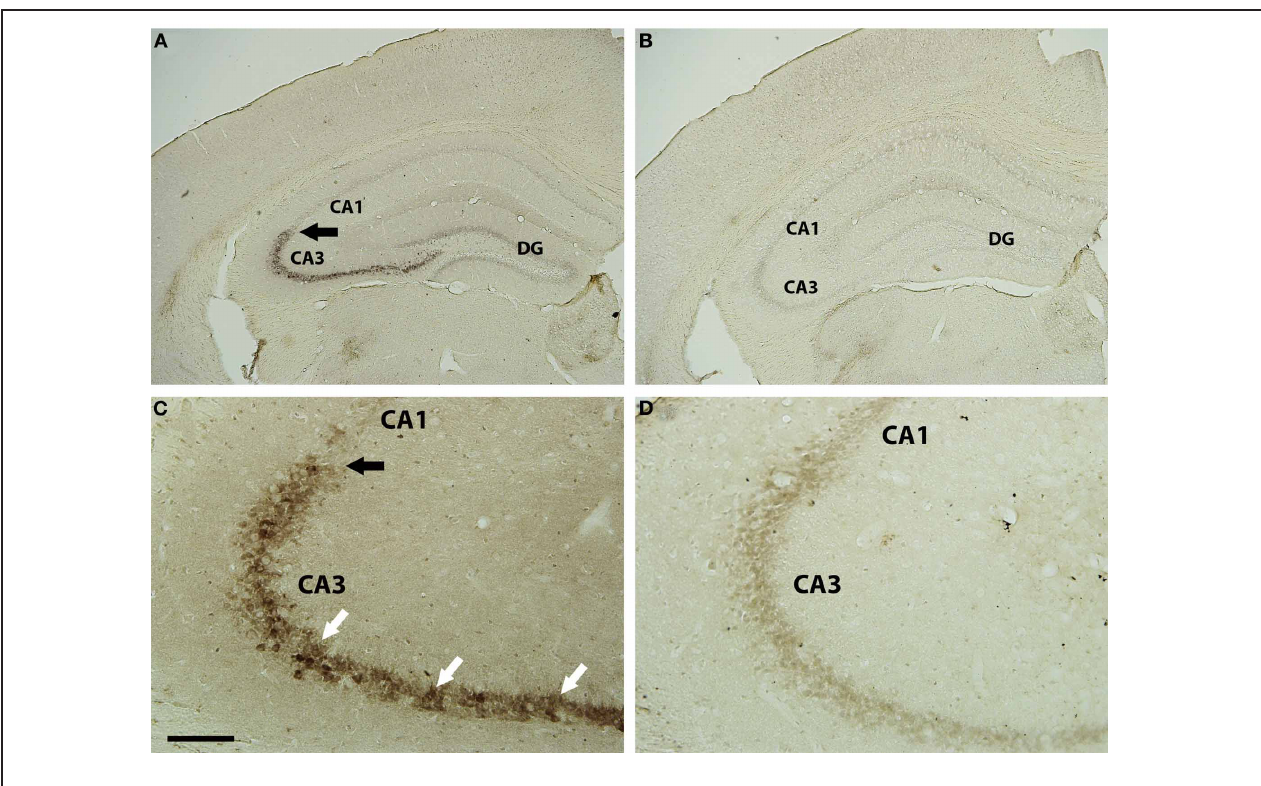
FIGURE 2 | Brightfield WGA immunostaining in hippocampus of DBH-WGA (A,C) and wild type (B,D) mice. CA3 pyramidal cell bodies (A) were heavily filled with reaction product for WGA (white arrows in C ). There was a clear demarcation at the CA3 border, with